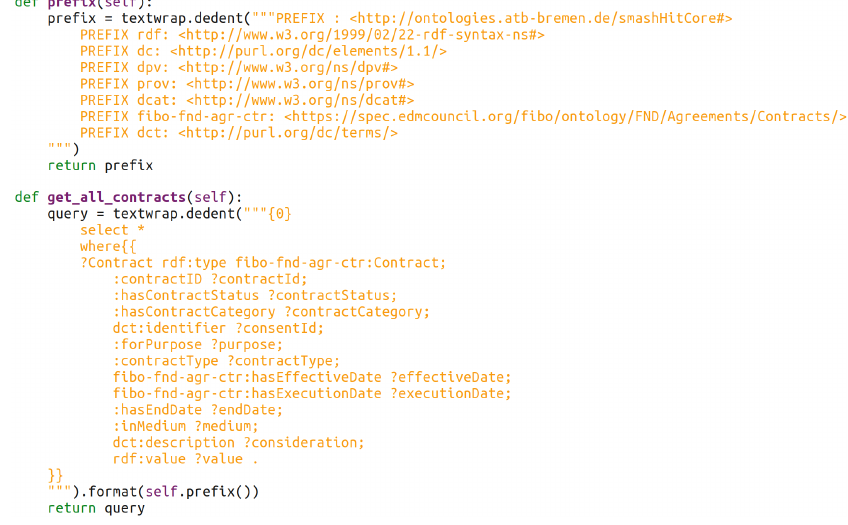
Figure 8. A snippet of code from the query processor